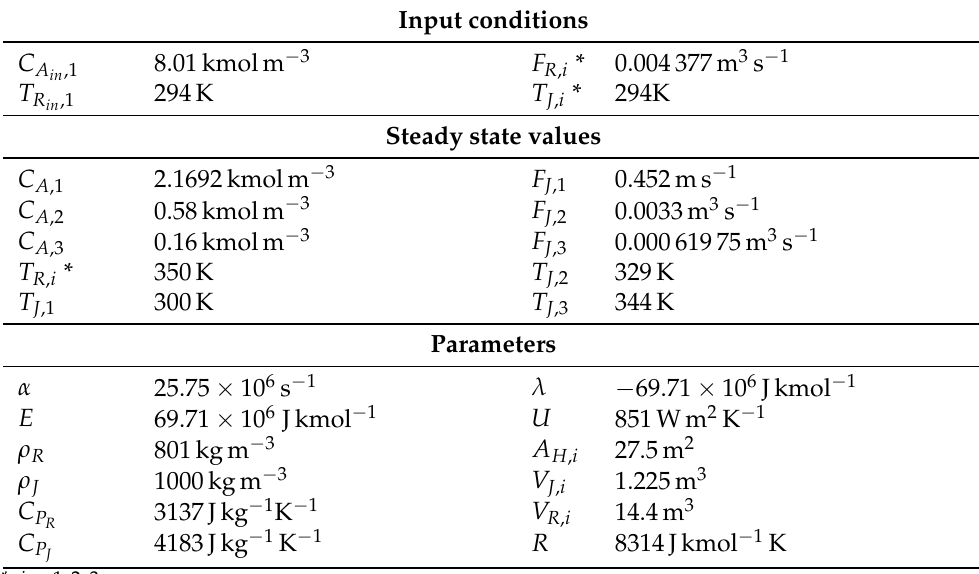
Table 1. Nominal operating conditions and